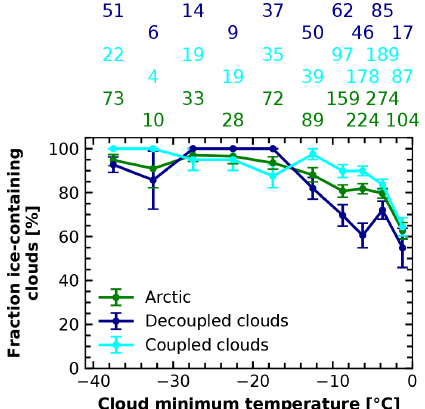
Figure A1. Same as Fig. 4 but using the cloud radar for ice detec- tion. In green the results of the complete data set are shown, in cyan for the coupled clouds, and in dark blue for the decoupled clouds.